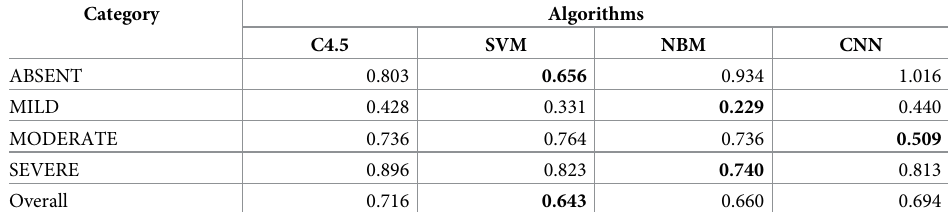
Table 3. A comparison of the classification performance of popular text classification algorithms and a basic CNN model on the normalised training set. The Best Score for Each Category is Highlighted in